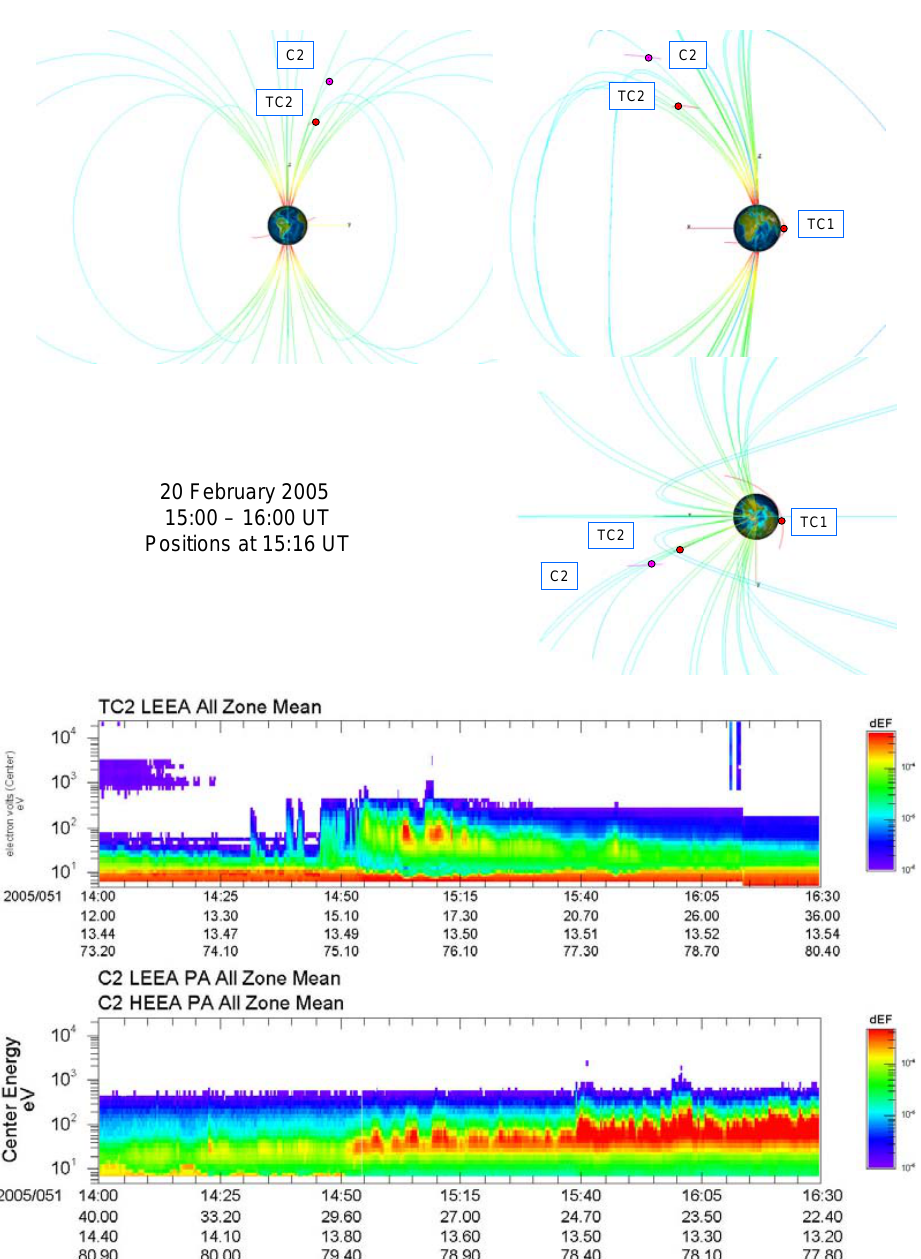
Fig. 16. Above, 20 February 2005, orbital positions and OVT model magnetosphere in GSM, views from X, Y and Z; below, PEACE data from TC-2 and C2 (TC-1 at perigee) X-axis labels show UT time, L-shell, MLT and invariant